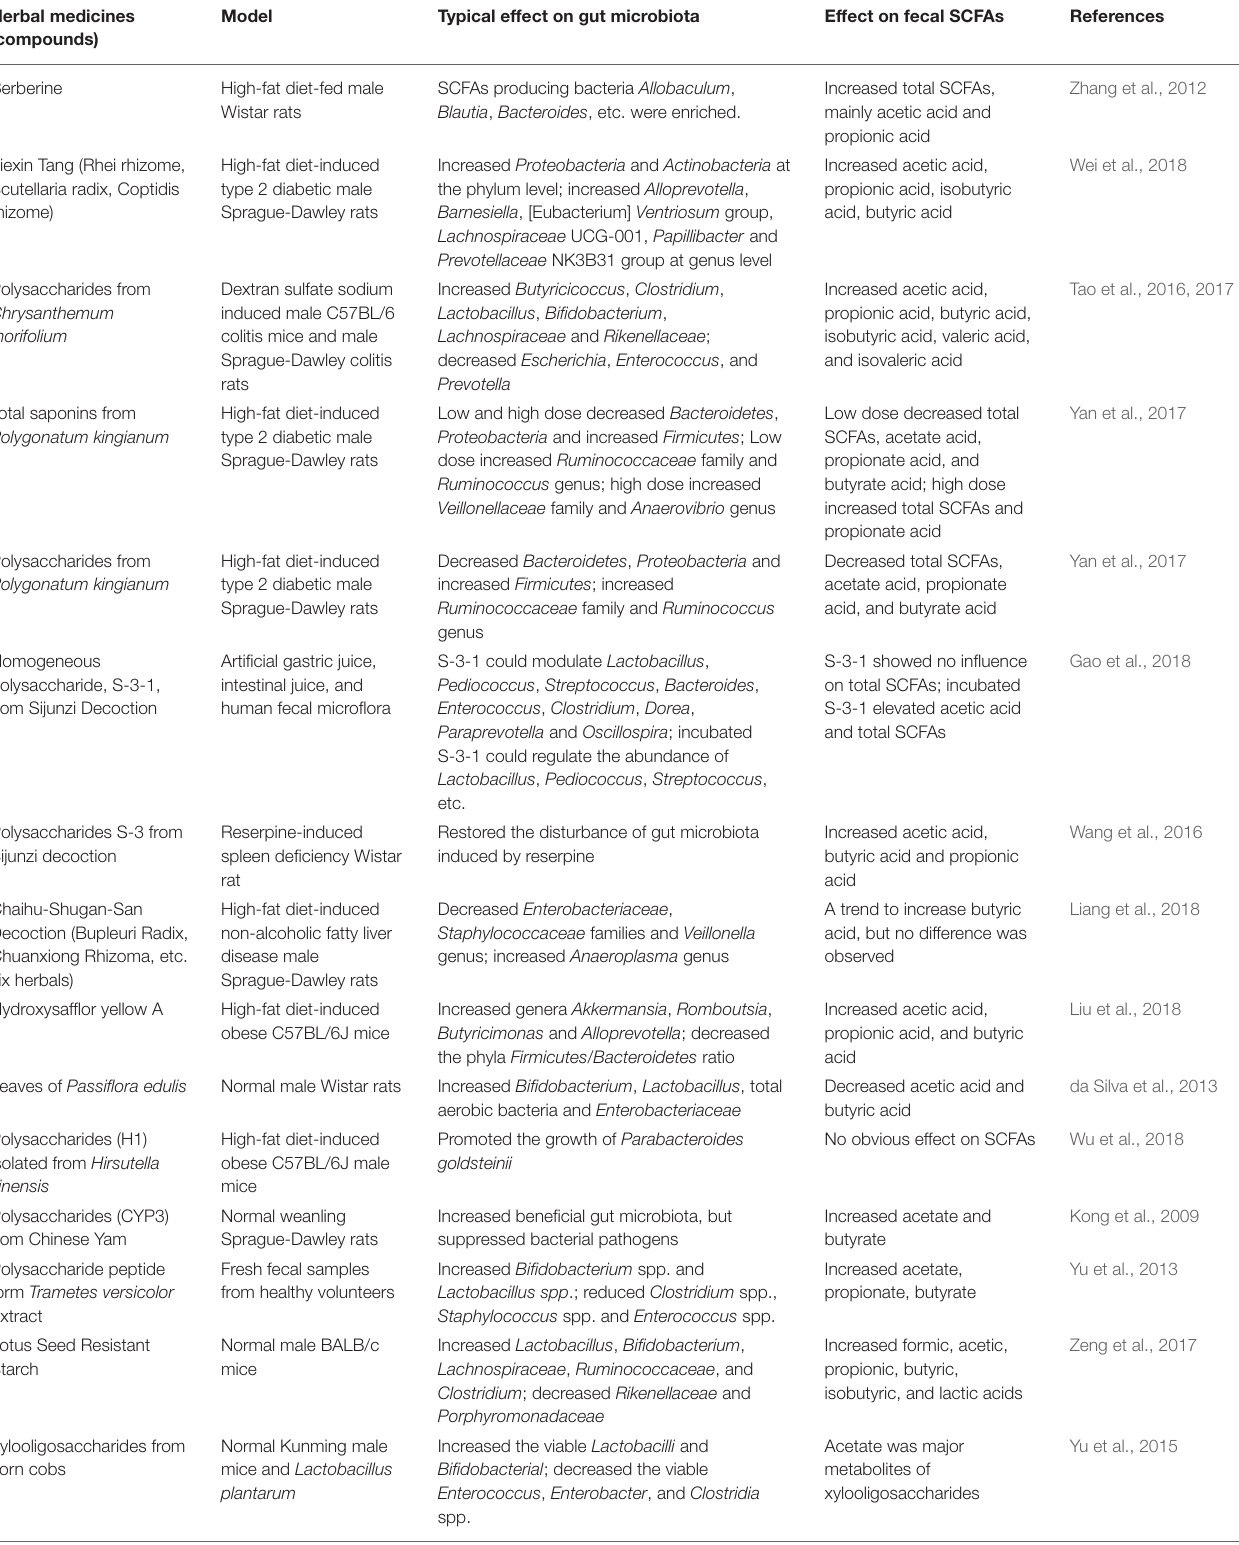
TABLE 2 | The effect of herbal medicines on gut microbiota and short-chain fatty acids (SCFAs). Herbal medicines